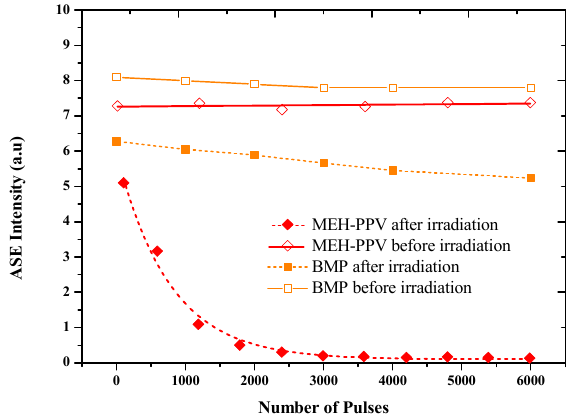
Figure 7. The photochemical stability of the CPs at a 100 μ M concentration.